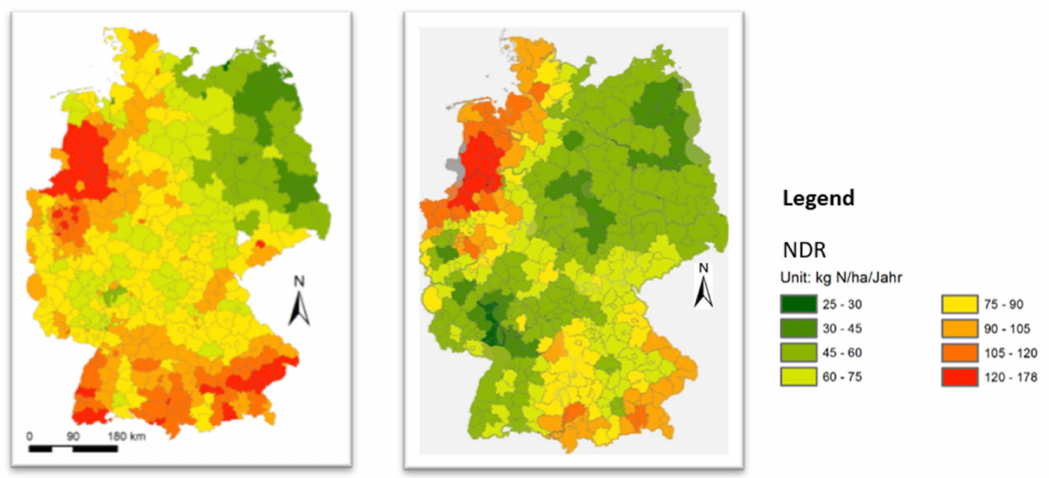
Figure 4. ( left ) The map shows an average nutrient load per hectare that reaches the river InVEST, while ( right ) is the nutrient balances for different regions according to